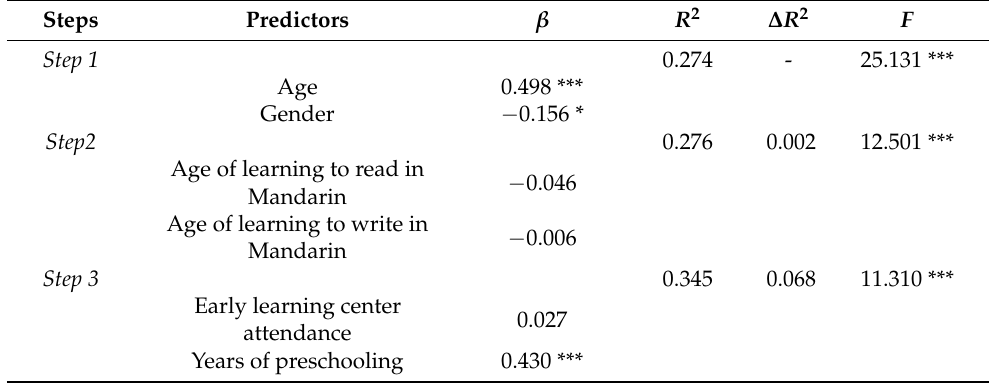
Table 7. Summary of Hierarchical Regression Analyses Predicting Frequency of Aspect